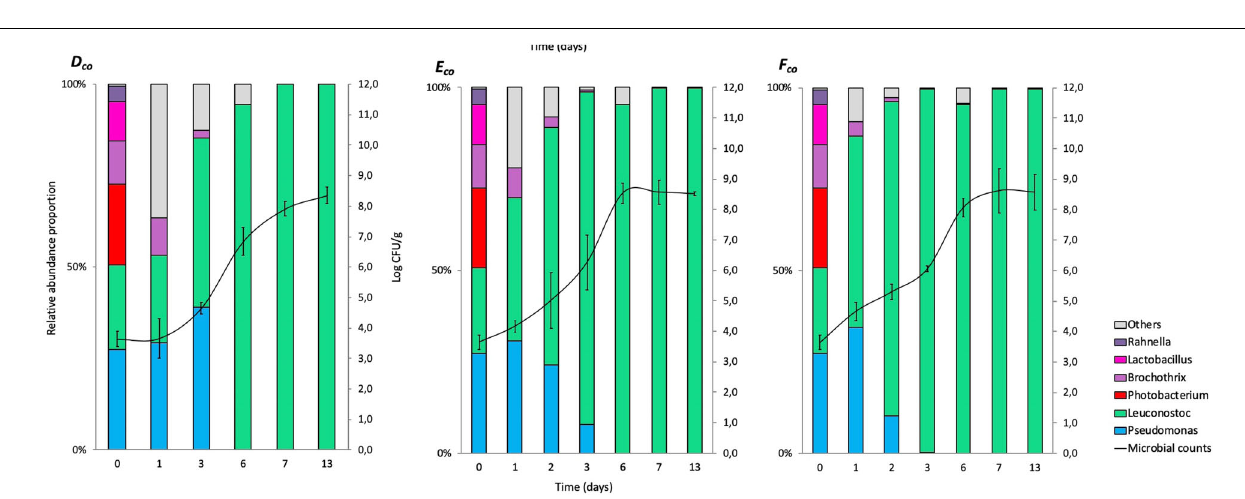
FIGURE 2 | Cumulated histograms of the relative abundance (%) of taxa and the dynamics of the bacterial community identified by metagenetics at genus levels in co-culture experiment during storage in food wrap ( A co , at 4 ◦ C; B co , at 8 ◦ C; C co , at 12 ◦ C). At genus levels, the taxa representing < 1% in relative abundance were merged in the category of “Others.” The solid represents the plate counts (means and standard deviation of the three replicates).